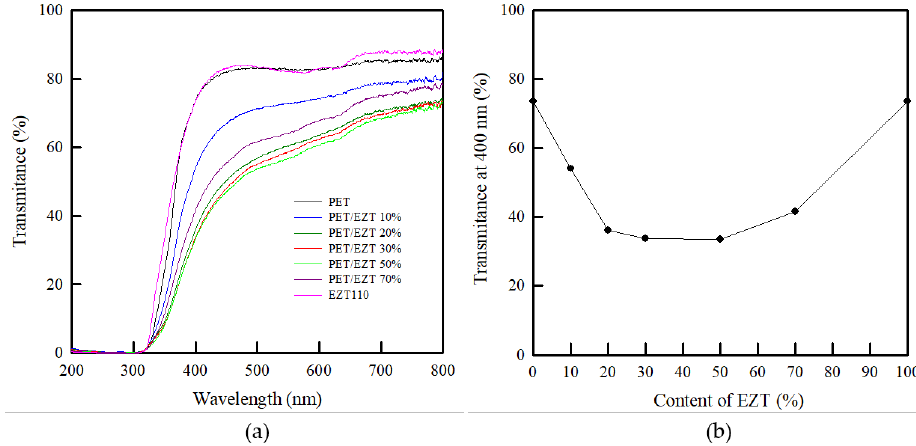
Figure 7. ( a ) UV-vis curves and ( b ) transmittance at 400 nm of the PET/EZT